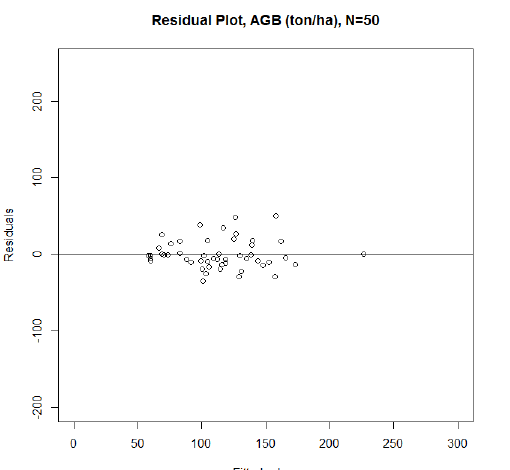
Figure 5. The residuals plots of ALS predicted AGB at phase